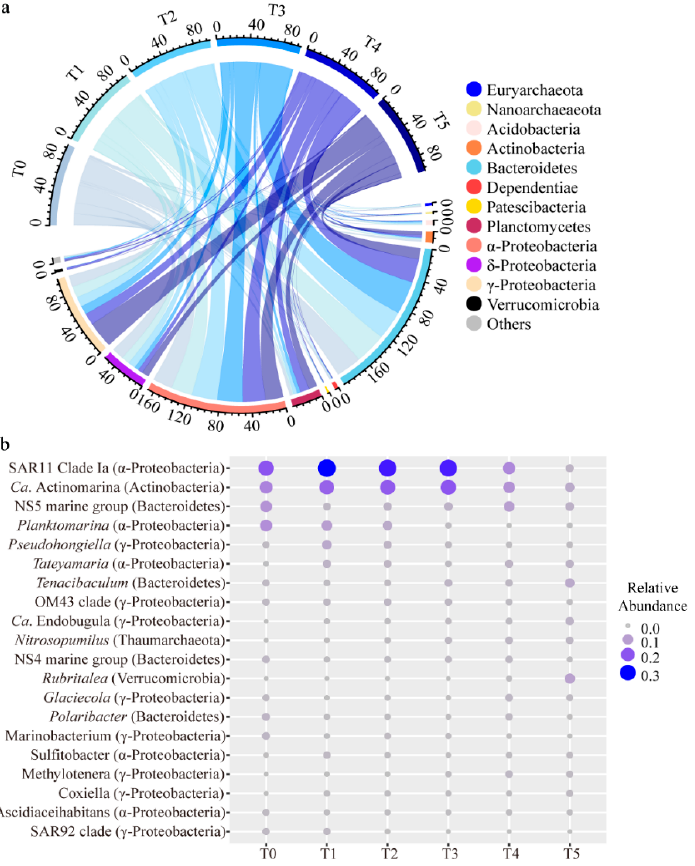
Figure 3. Temporal changes in the relative abundance of the prevalent microbial taxa. ( a ) Microbial compositions displayed at the phylum or Proteobacterial class level. ( b ) The most abundant taxa at the genus